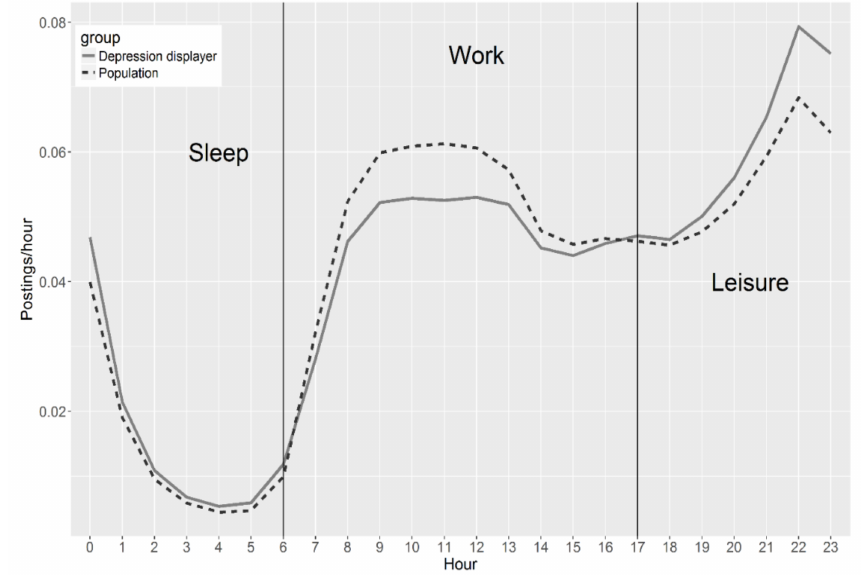
Figure 3. Diurnal trends (average number of postings posted hourly throughout a day).